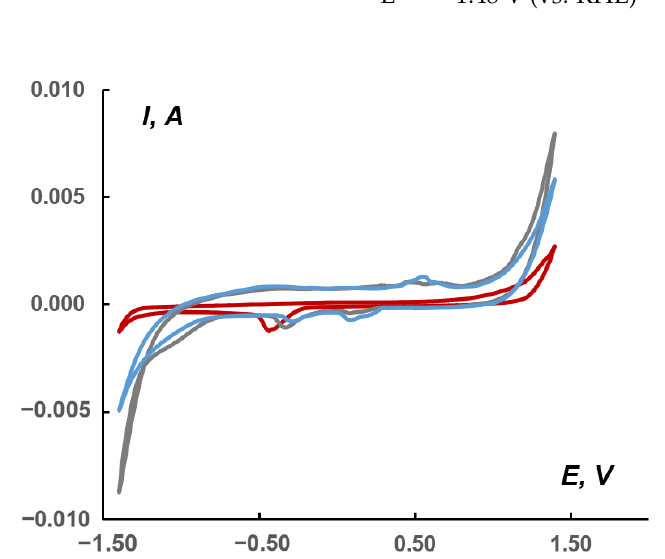
Figure 8. CVs (second cycle) for the following pastes: red curve — blank in the CO 2 saturated solution (without electroactive compound); blue — containing 1 ; and gray — containing 1 in the CO 2 saturated solution; 1.0 M KHCO 3 aqueous solutions at 10 mV/s scan rate. Potentials vs. saturated Ag/AgCl reference electrode.